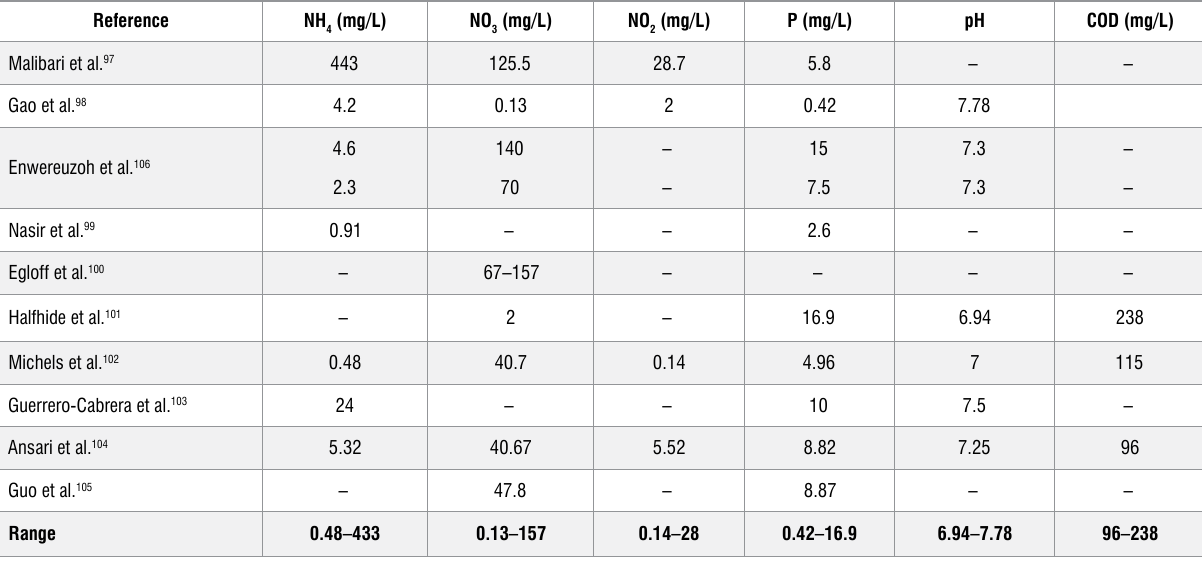
Table 5: Characteristics of aquaculture wastewater used for cultivating microalgae